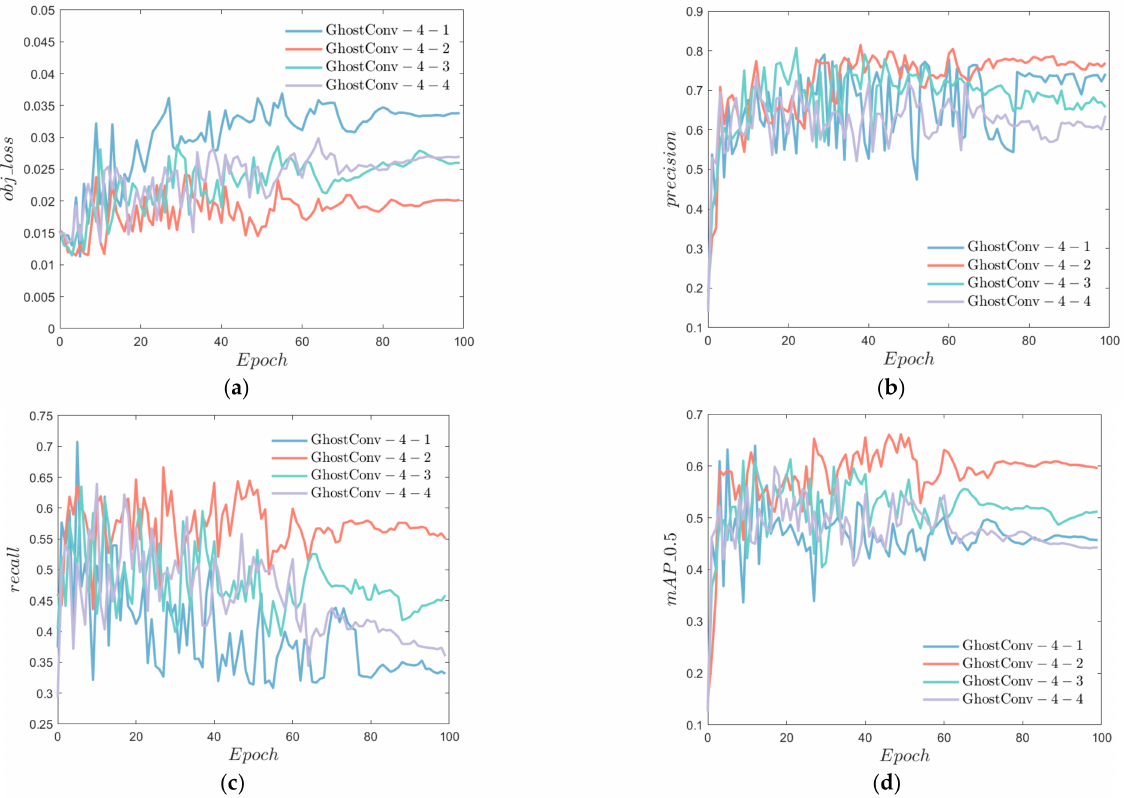
Figure 11. Comparison of the number of GhostConv replacements. ( a ) Confidence loss. ( b ) Accuracy rate. ( c ) Recalling rate. ( d ) mAP